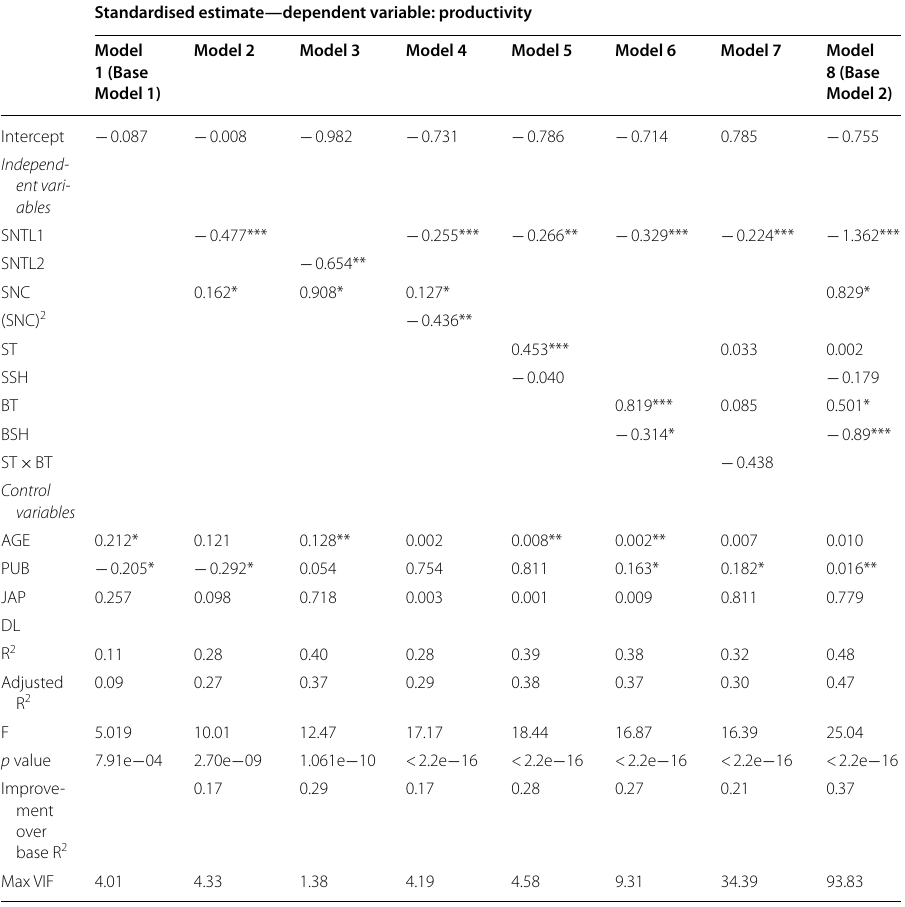
Table 6 GLS regression results—productivity Standardised estimate—dependent variable: